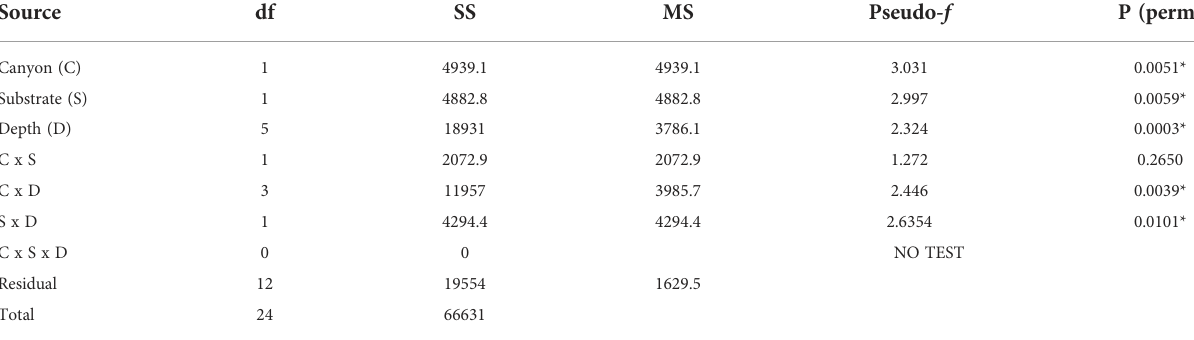
TABLE 3 PERMANOVA, Type1 (sequential) fi xed effects on a permutation of residuals under a reduced model (9999 number of permutations), results of differences in benthic assemblages in canyon (canyon vs. non-canyon), substrate, and depth groups - where * shows signi fi cant values. Source